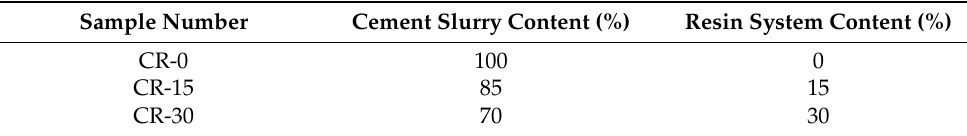
Table 3. Volume proportion of resin and cement slurry in resin-modified cement paste.